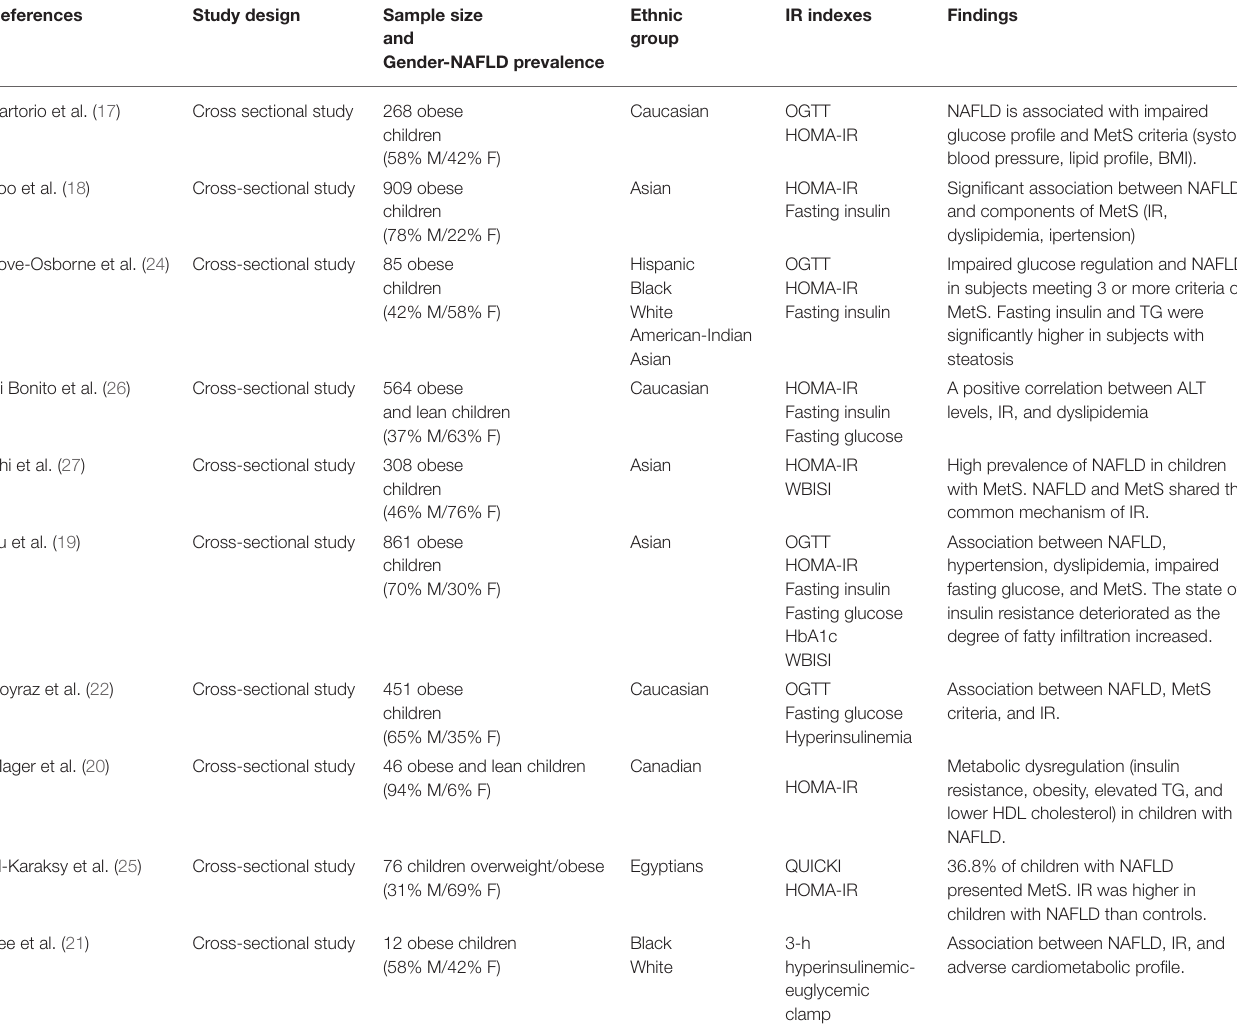
TABLE 1 | Studies evaluating the association between insulin resistance, non-alcoholic fatty liver disease (NAFLD), and metabolic syndrome (MetS) in